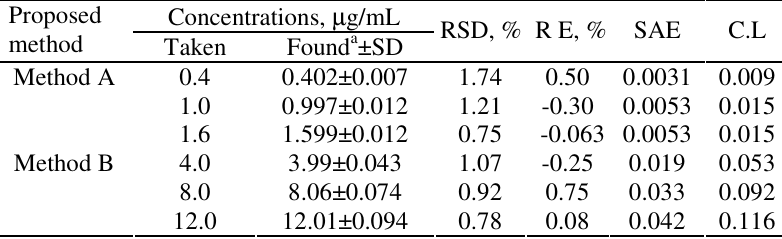
Table 2 Evaluation of precision and accuracy